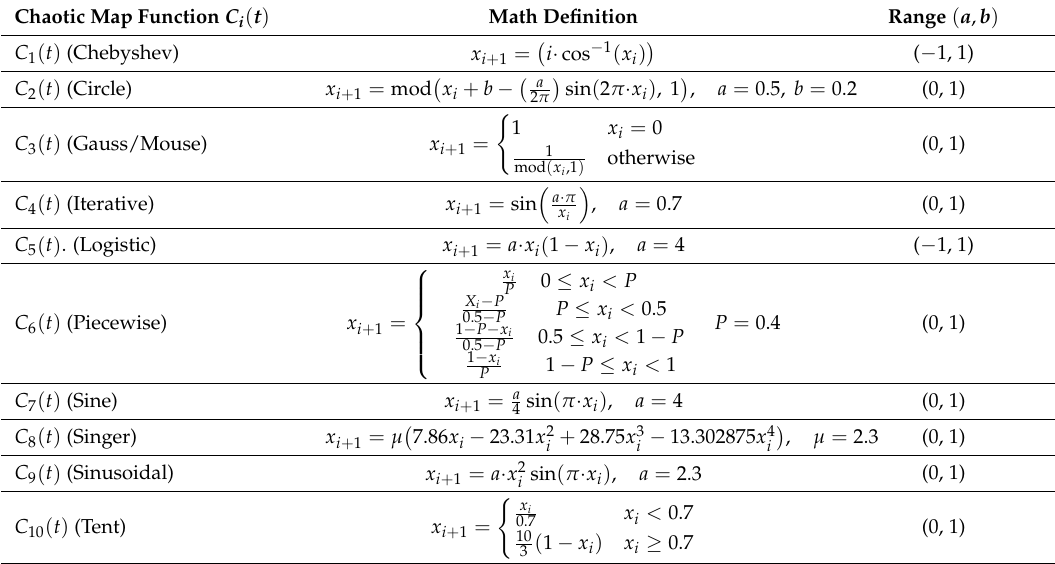
Table A1. Chaotic map functions for the proposed CGSA-based PV cell parameter identification approach. The initial value for all of the implemented functions starts at x 0 =